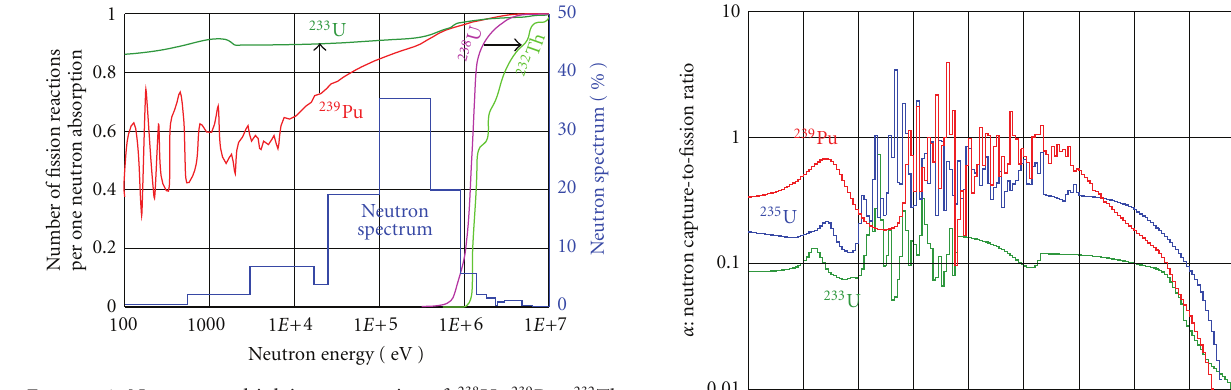
Figure 6: Neutron-multiplying properties of 238 U, 239 Pu, 232 Th, 233 U, and neutron spectrum in lead-cooled fast reactor BREST-300.